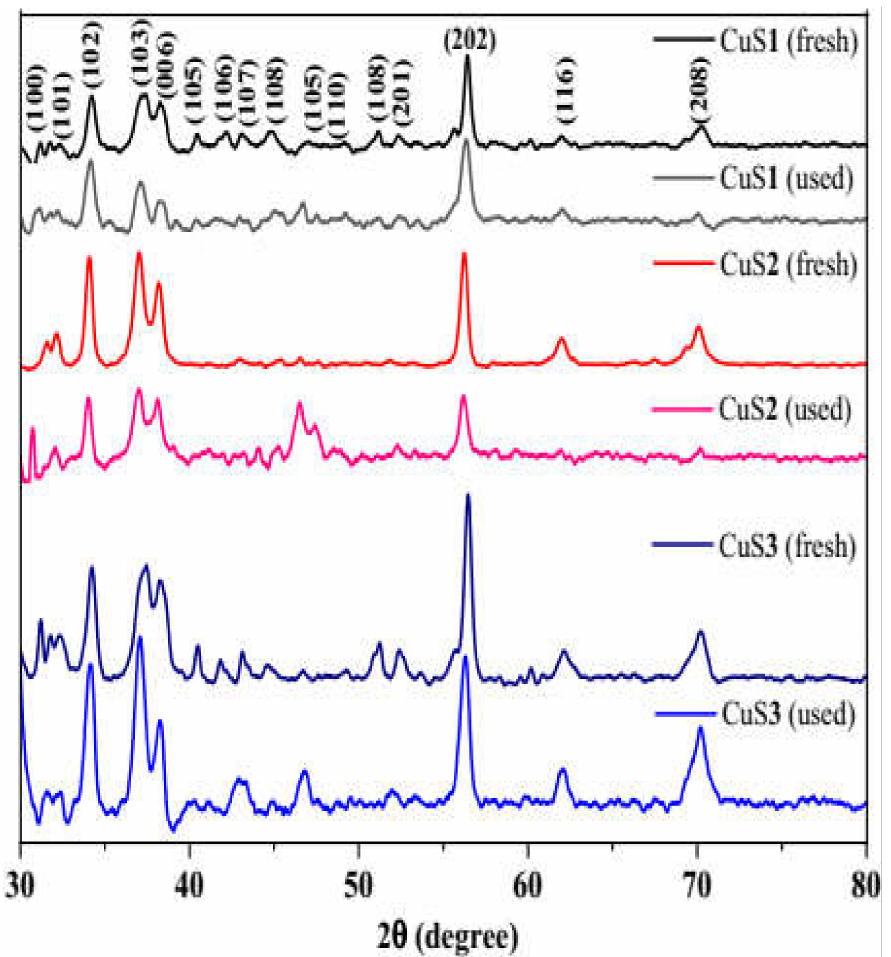
Figure 1. Comparison of XRD patterns of CuS nanoparticles for fresh and after photocatalysis (after four